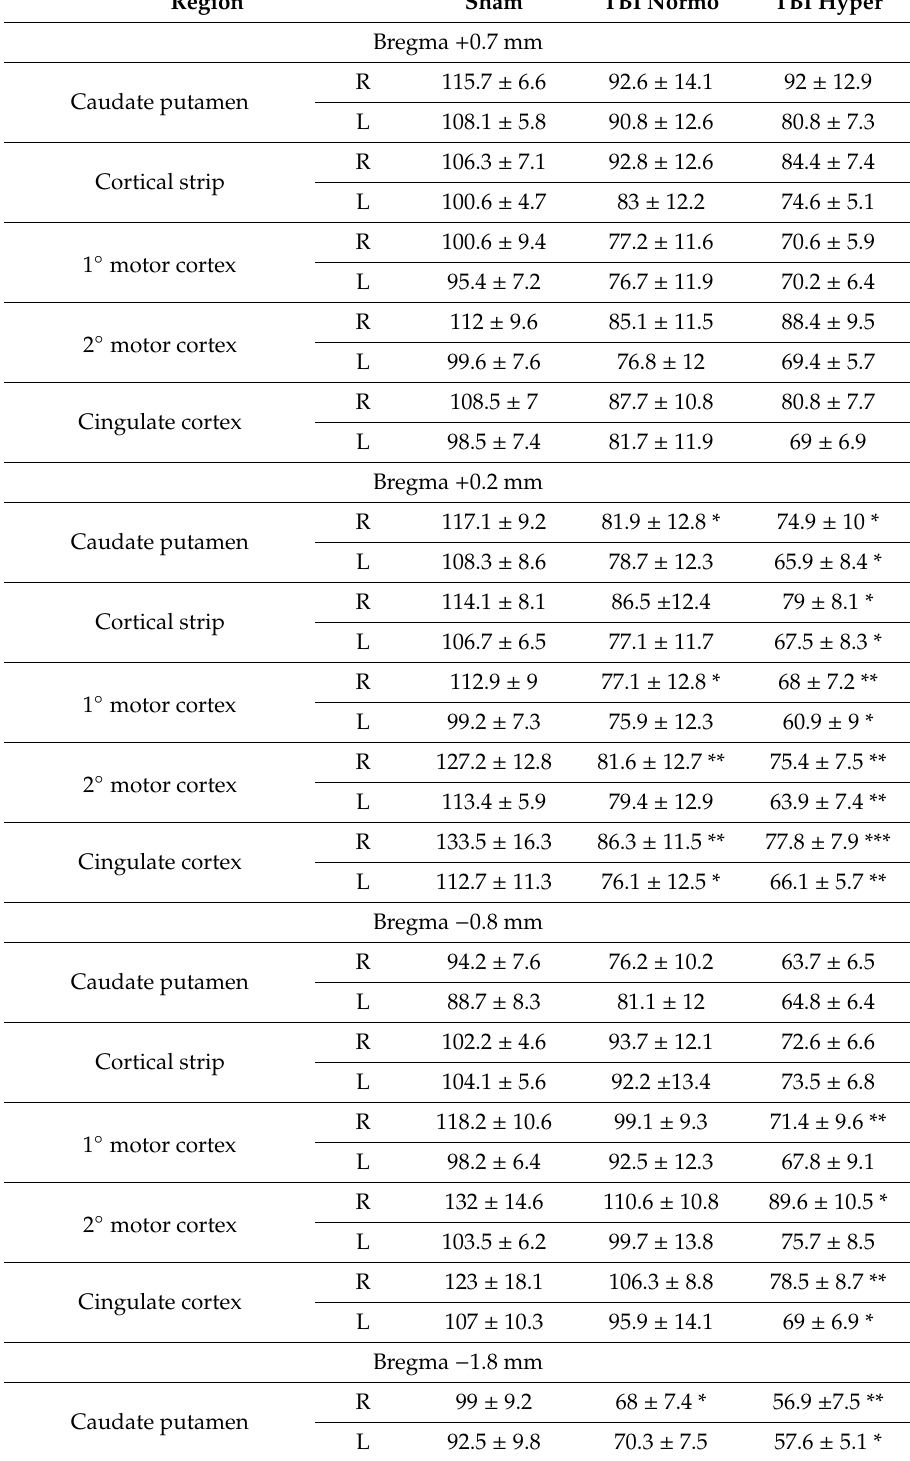
Table 2. Values represent local cerebral metabolic rate of glucose as mean ± standard error of the mean ( µ mol / 100g / min; n = 7–8 per group) of each region of interest (ROI) across nine bregma levels. Two-way ANOVA analyses showed significant di ff erences between sham and triple-hit mild TBI (mTBI) groups. Hyperthermia conferred a higher degree of significance in a ff ected ROIs. * p < 0.05, ** p < 0.01, *** p < 0.001, and **** p < 0.0001, where indicated against the sham group. There were no significant di ff erences between the two TBI